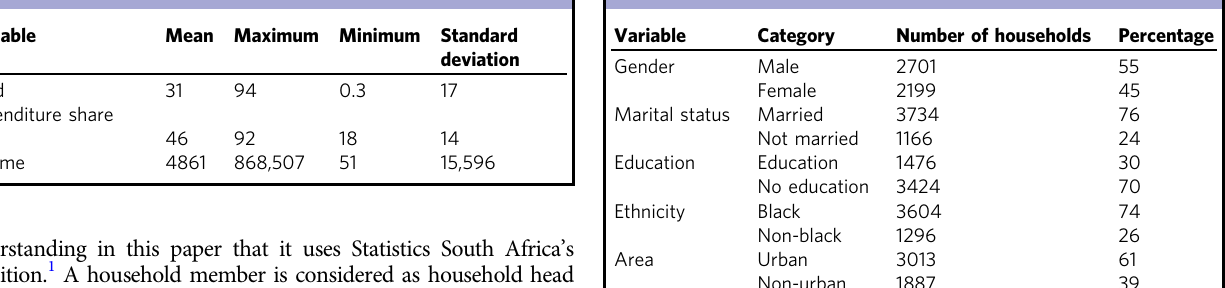
Table 2 Summary statistics of continuous variables. Table 3 Summary of categorical